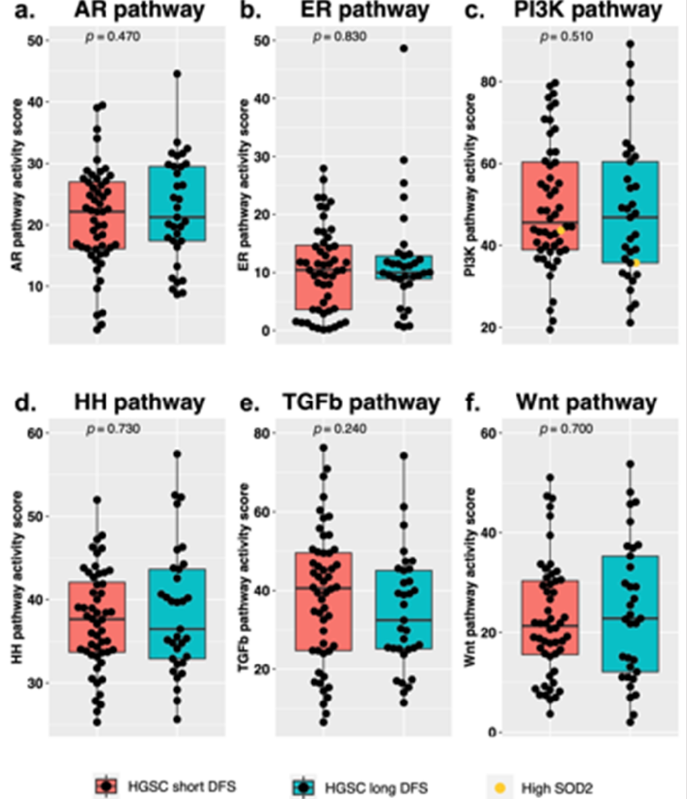
Figure 1. Signal transduction pathway activity measured in high-grade serous ovarian carcinoma (HGSC) samples in the short and long disease-free survival (DFS) groups, for the ( a ) androgen receptor (AR), ( b ) estrogen receptor (ER), ( c ) phosphoinositide-3-kinase (PI3K), ( d ) Hedgehog (HH), ( e ) transforming growth factor beta (TGF- β ) and ( f ) canonical wingless-type MMTV integration site (Wnt) pathway. p -values were obtained from a Mann–Whitney U test. The samples with high SOD2 levels are marked in yellow. “HGSC short DFS” refers to a DFS below 12 months and “HGSC long DFS” refers to a DFS over 24